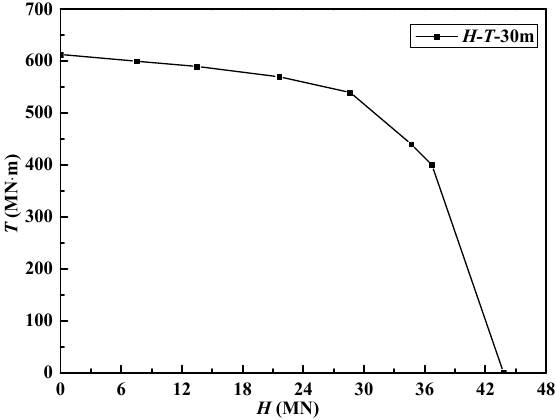
Figure 22. Failure envelope in H–T load space.